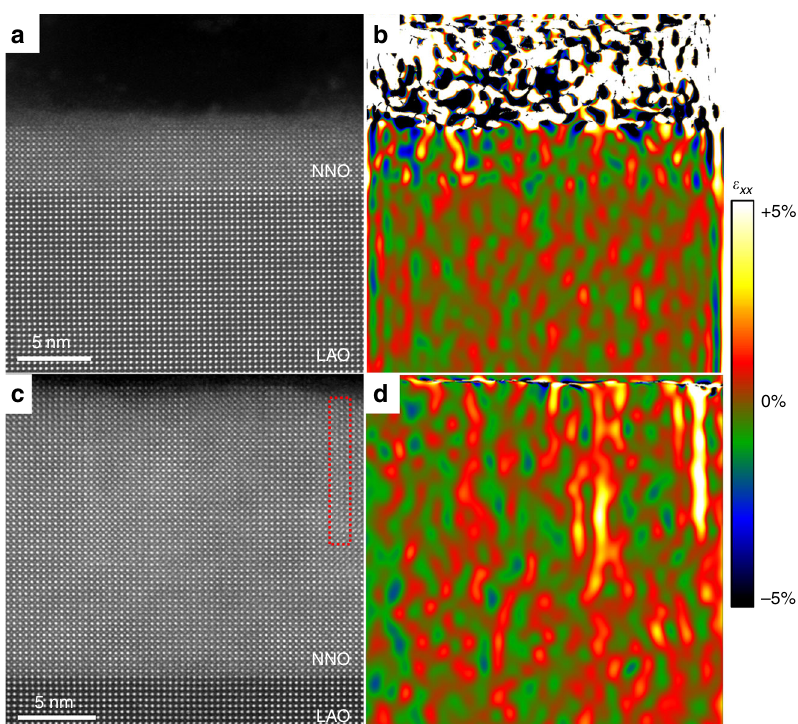
Fig. 4 Atomic image and strain in NNO/LAO. Cross-sectional HAADF-STEM image of NdNiO 3 thin fi lms grown on LaAlO 3 substrates, for a 5-nm-thick fi lm ( a ) and a 20-nm-thick fi lm ( c ). The respective in-plane components of the strain tensor ( ε xx , colour scales) obtained from the STEM images by geometrical phase analysis (GPA) are shown in b and d . The red dashed lines surround the RP